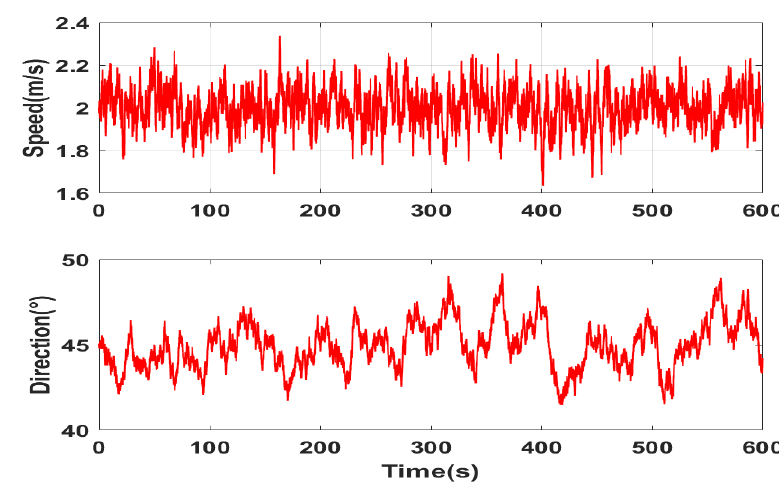
Figure 6. Simulation diagram of current speed and direction.